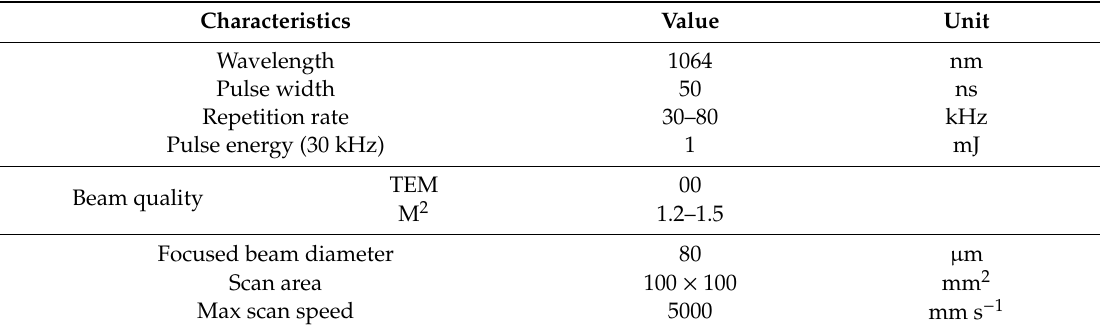
Table 2. Main characteristics of the laser system used for S-SiC treatments.